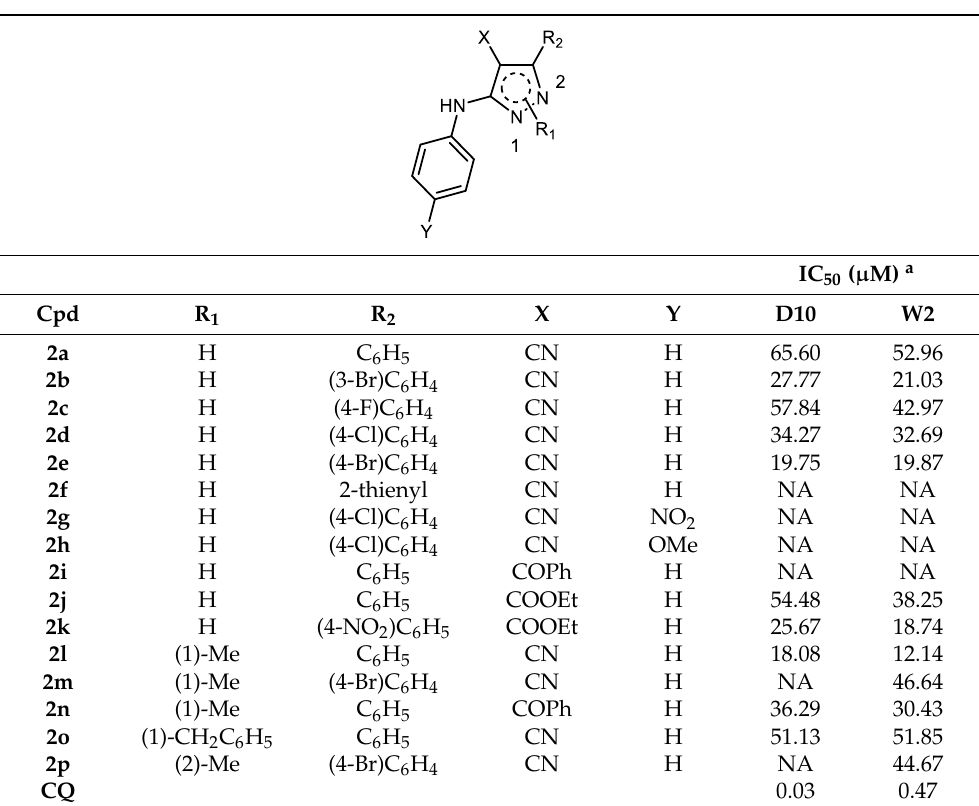
Table 1. Antiplasmodial activity of 5-anilinopyrazoles 2 .